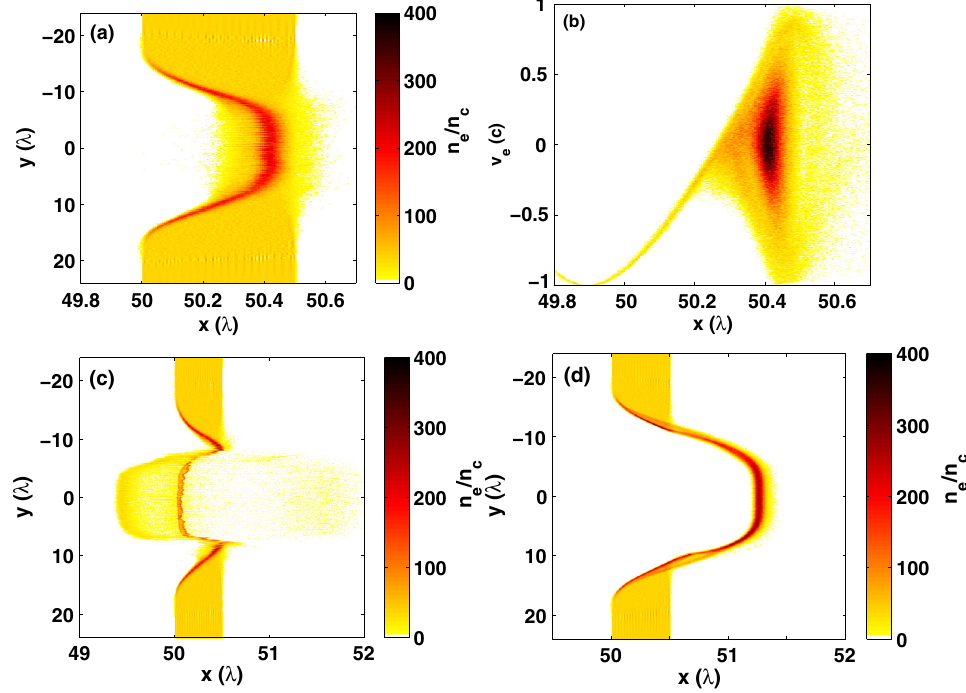
FIG. 6. 2D simulation results for n 0 ¼ 40 n c , l 0 ¼ 0 : 5 (cid:3) . (a) Electron-density distributions and (b) phase-space distribution for the electrons in the region j y j (cid:6) 5 (cid:3) at t ¼ 55 T are plotted. Here, a 0 =t up ¼ 29 ( a 0 ¼ 50 , t up ¼ 1 : 72 T ). Distributions of electron density at t ¼ 55 T for (c) fixed and (d) moving ions for a